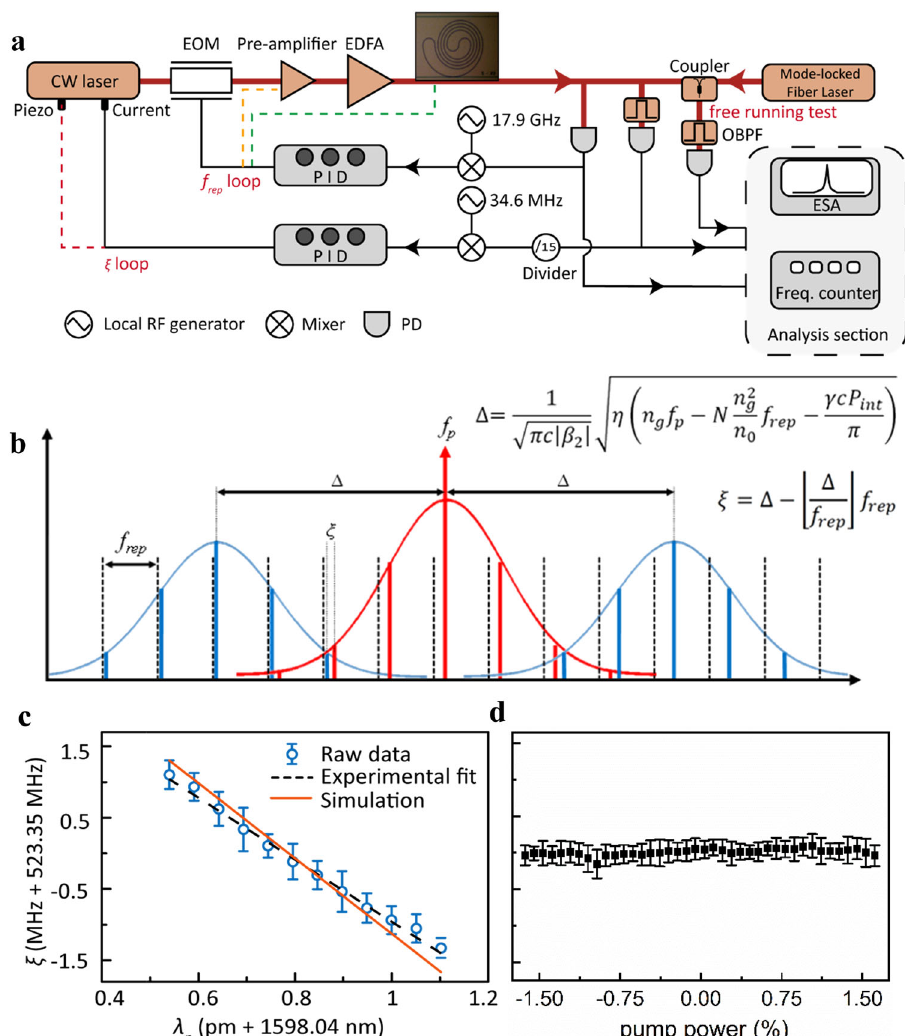
Fig. 2 Dual-microwave control comb stabilization principle. a Frequency microcomb setup for stabilization. Here EOM, Electro-optic modulator; EDFA, Erbium-doped fi ber ampli fi er. For ξ and f rep stabilization, an EOM controls the pump power and the ECDL diode current controls the pump laser frequency, through two phase-locked loops. We also note that, in place of the EOM, a polarization rotator with a PBS can also serve for intensity modulation. To increase the locking duration, we implemented slow control of the ECDL PZT (red dashed line) and the EDFA gain (yellow dashed path). The slow feedback to the EDFA gain may also alternatively be replaced by sending the feedback signal to the temperature controller on the chip holder (which controls device temperature) instead (green dashed path). This reduces loop dynamic range but also mitigates the effects of ambient temperature drift. The stability of the locked microcomb is interrogated out-of-loop by beating with an independently stabilized fi ber frequency comb. b Frequency domain illustration of the demonstrated full-stabilization technique. Here the offset frequency, ξ , is linked with the primary comb line spacing, Δ , by the constitutive relation ξ ¼ Δ (cid:2) Δ f rep the group index, n o is the refractive index, N is the longitudinal mode number, c is the speed of light in vacuum, γ is the nonlinear coef fi cient, and P int is the intracavity pump power. c Subsequent to f rep stabilization, the offset frequency shows strong linear correlation with pump wavelength (blue circles) with a slope of about 4.5 MHz per picometer shift of pump. The simulated slope (plotted in orange) also shows good agreement with measured data. d Measured offset frequency as a function of applied pump power, after f rep stabilization. The pump power is stepwise changed by a total of 3.4% via the EFDA gain. The offset frequency remains constant within the error bar, verifying that f rep stabilization effectively eliminates the intracavity pump power fl uctuation. For ( c ) and ( d ), 10 measurements are taken to determine the mean value, and the error bars are de fi ned as the peak-to-peak deviations from the 10 measurements. Here the pump frequency is not yet stabilized, resulting in the error bars in the offset frequency eliminates the intracavity pump power fl uctuation and reduces the dependence of ξ to just a function of pump frequency. Mode hybridization in the current multi-mode Si 3 N 4 microresonator leads to abrupt increase of local GVD and results in the pinning of primary comb lines. 55,56 The effect reduces the slope, i.e . sensitivity, of offset frequency in gauging the pump frequency fl uctuation (Eq. 4). Nevertheless, the sensitivity is already more